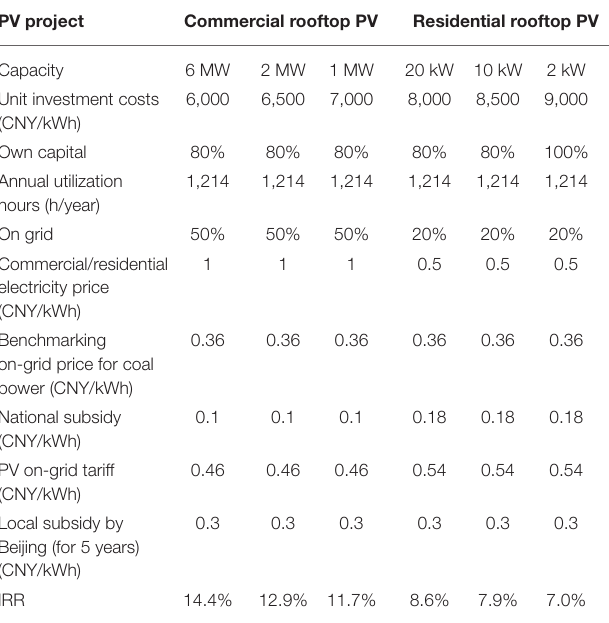
TABLE 2 | Common parameters for economic analysis of rooftop PV.